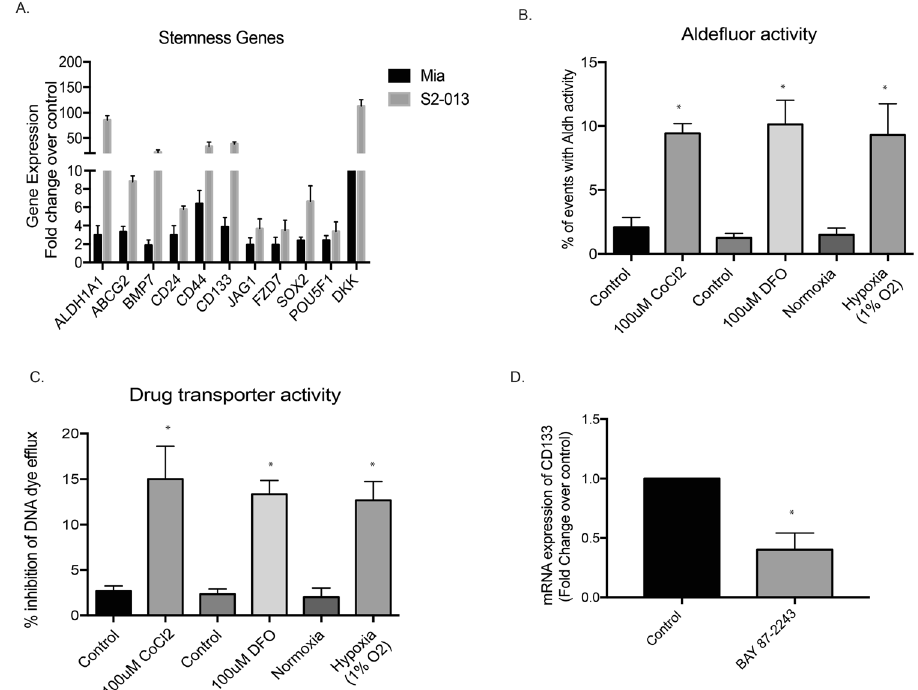
Figure 6. Hypoxia and stemness: Exposure of pancreatic cancer cells to hypoxia resulted in increased expression of stemness genes ( A ). In addition, Aldh activity, a known phenotypic marker of cancer stem cells, measured by Aldefluor was increased upon exposure to hypoxia or its chemical mimetics ( B ). In addition, upon activation of hypoxia mediated signaling, increased drug transporter activity was observed ( C ). Treatment with Minnelide decreased stemness in pancreatic cancer